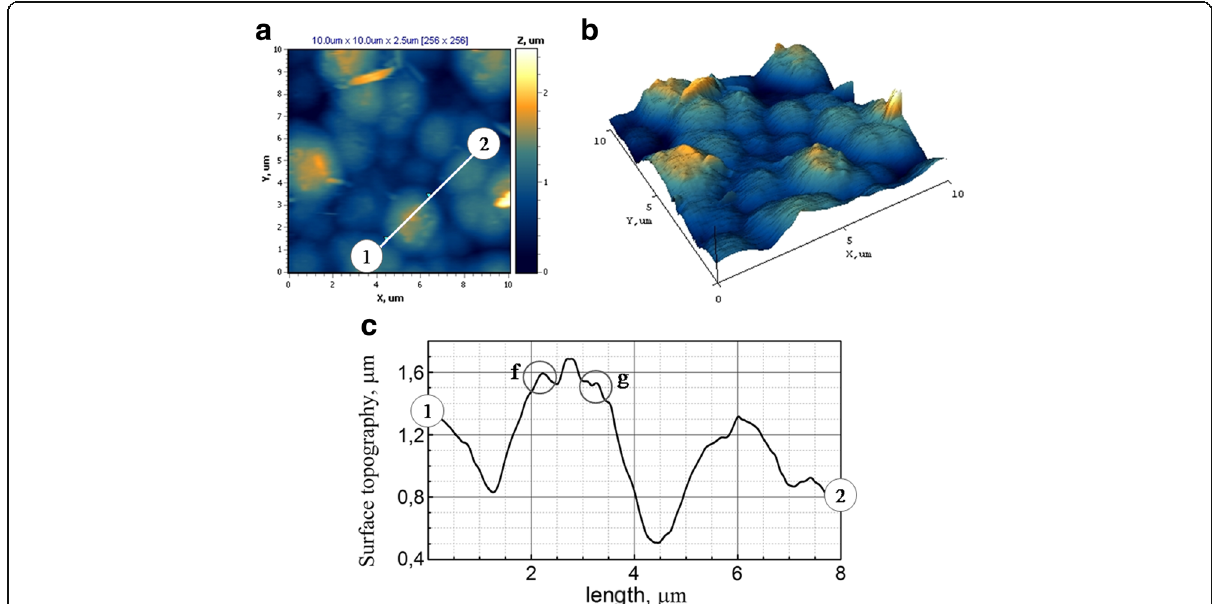
onto mild steel substrate. Scan area AFM 10.0 × 10.0 μ m